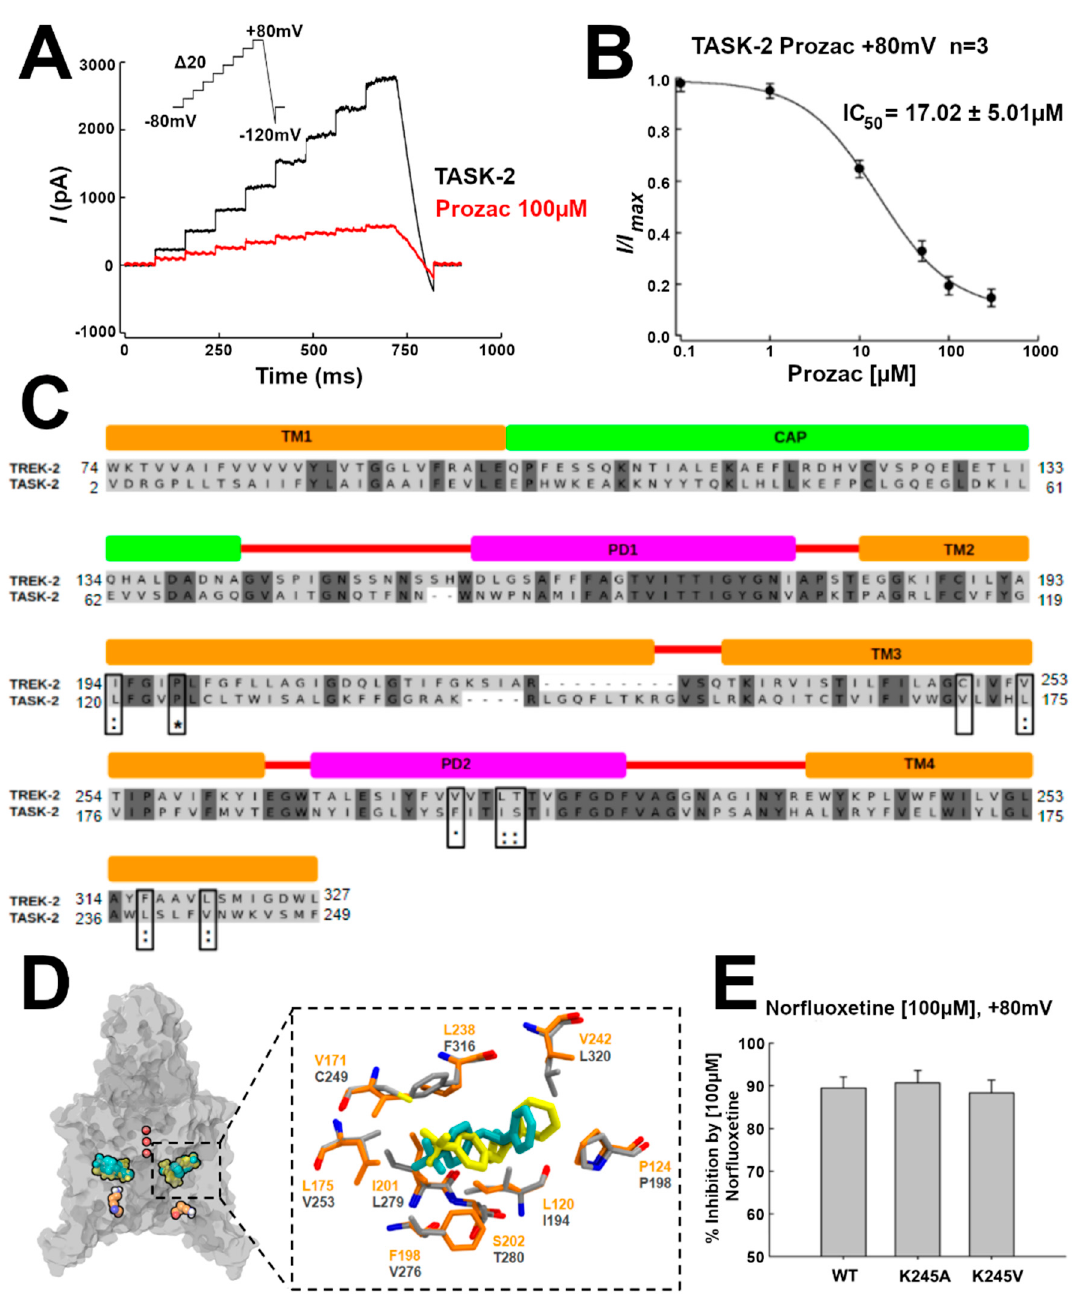
Figure 4. TASK-2 is blocked by Prozac. ( A ) Whole-cell recordings showing the effect of Prozac (100 µM) on TASK-2 channels. The currents were evoked using the voltage protocol from − 80 to +80 mV (see inset); ( B ) Concentration–response curve with the IC 50 value of TASK-2 inhibition by Prozac. The block was analyzed at the end of the test pulse at +80 mV; ( C ) Docking of Prozac in the T2Tre2OO structure (yellow) shows a similar position as Prozac in the TREK-2 crystal structure (cyan). Prozac binding site residues in TREK-2 are shown in gray, whereas the homologous residues in TASK-2 are in orange. The protein is shown in transparent surface representation. The ions in the selectivity filter are red. K245 residues are shown as reference in orange; ( D ) Pairwise sequence alignment between TREK-2 and TASK-2 channel [27]. Prozac binding site in TREK-2 is composed by residues of TM2, TM3, PD2, and TM4. They are conserved in TASK-2 channel. * Identical residues; : very conserved residues; ∙ conserved residues; ( E ) Percentage of inhibition by 100 µM Prozac of wild-type TASK-2 and two mutants of K245 residue. Results are shown as means ± Standard Error of the Mean (SEM).